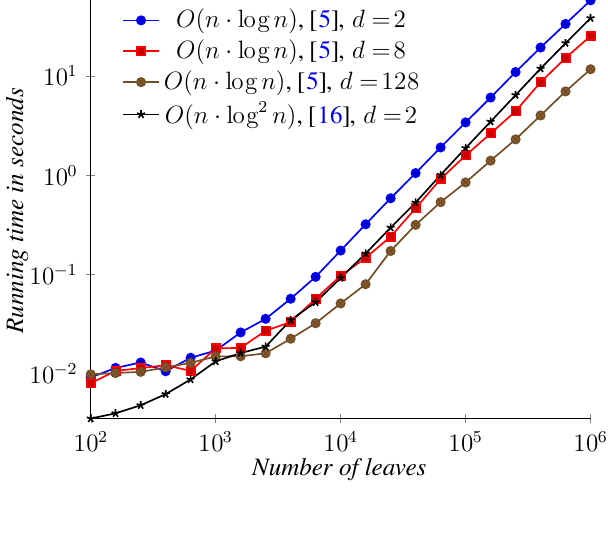
Figure 16. Triplet distance running time. For the O ( n log 2 n ) time algorithm, which only handles binary trees, results are only shown for a degree of d = 2 , while for the general algorithm, results are also shown for d = 8 and d = 128